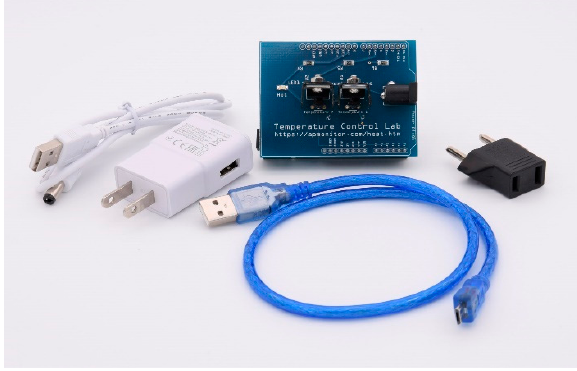
Figure 3. Temperature control lab (TCLab) hardware set.